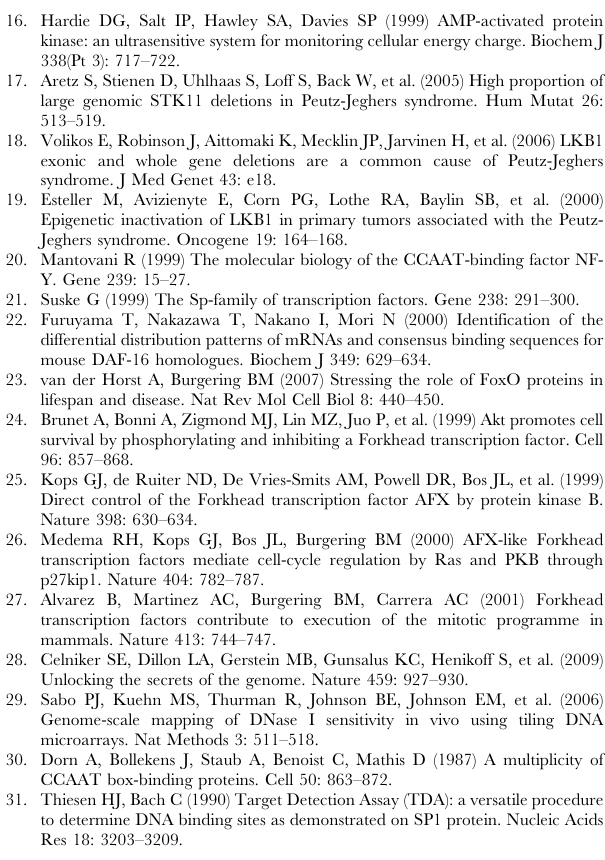
Table S1 Primer list. Sequences of primers used for PCR- amplification of LKB1 promoter fragments, full length open reading frames (ORF) of indicated transcription factors, site- directed mutagenesis of FOXO3 and FOXO4 ORFs and cDNA of indicated mRNAs after reverse transcription (RT-PCR). For RT-PCR experiments the annealing temperature, the